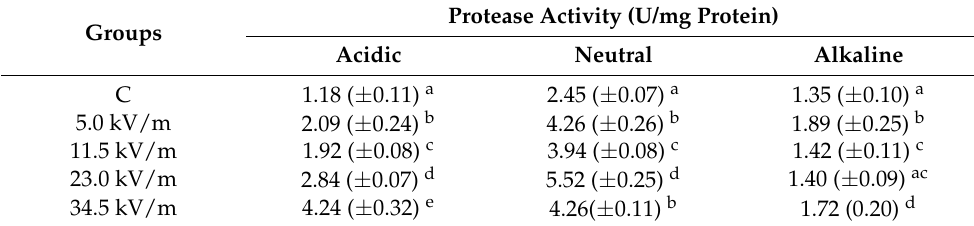
Figure 1. The average protease activity in bee organisms after 12 h under the influence of an E-field at 50 Hz and an intensity of 5.0 kV/m, 11.5 kV/m, 23.0 kV/m, or 34.5 kV/m. The group name is the E-field intensity to which the bees were exposed. The control group is marked with the letter C. Table 1. Comparison of protease activity between all